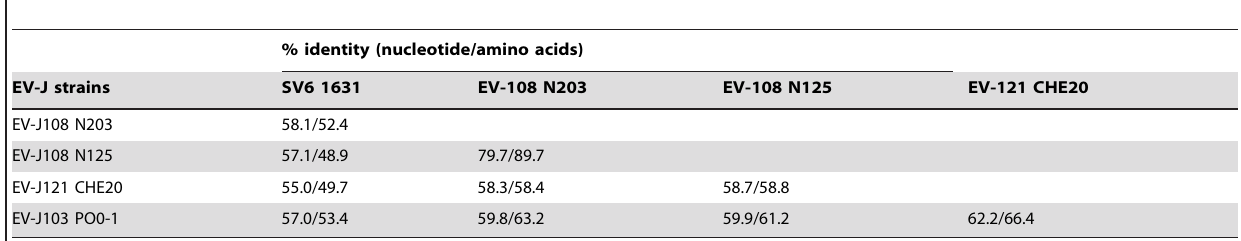
Table 3. VP1 sequence relationships between the newly sequenced EV-J121 and other currently recognized EV-J strains.